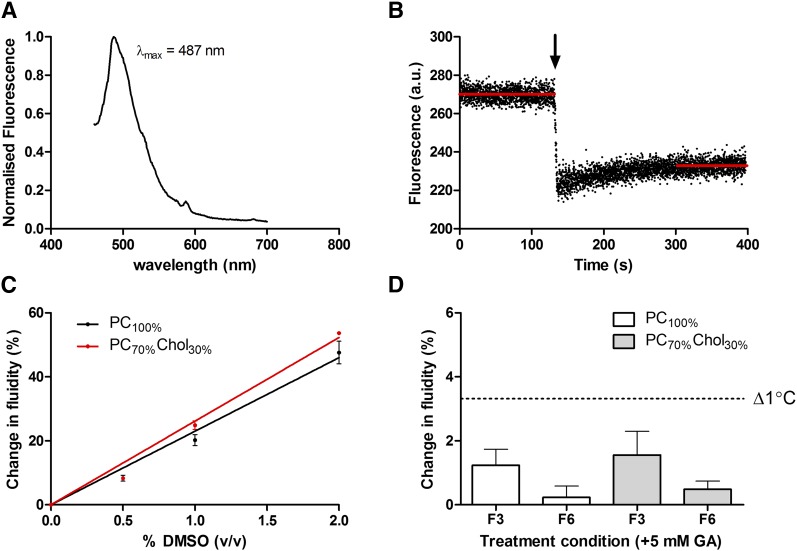
The influence of F3 and F6 on membrane fluidity. A: Normalized emission spectra of DCVJ-labeled PC100% liposomes (400 μM liposomes with 1.5 μM dye) in HEPES buffered saline (pH 7.4) at 37°C exhibits peak fluorescence emission of 487 nm, similar to that previously reported for PC liposomes (49). B: Addition of 2% DMSO to DCVJ-labeled PC100% liposomes at 37°C induced a reduction in DCVJ fluorescence indicative of an increase in membrane fluidity in agreement with the reported behavior of this molecule in PC- and cholesterol-containing membranes (53, 54). C: A concentration-dependent change in membrane fluidity (DCVJ fluorescence intensity ratio) was observed on addition of DMSO to PC100% and PC70%Cholesterol30% [PC70%Chol30%] liposomes at 37°C. On fitting this data to a linear regression model, DMSO was found to induce a significantly greater change in membrane fluidity in PC70%Chol30% membranes, perhaps indicative of disassembly of cholesterol-containing domains (extra sum-of-squares F-test, P = 0.0246). D: Addition of F3 and F6 to liposomes was observed to induce an increase in membrane fluidity with F3 modulating the membrane fluidity to a greater extent than F6. The extent of membrane fluidity modulation was, however, slight and less than that typically attributed to a change in temperature of 1°C (Table 2). As mammalian brain temperatures are reported to fluctuate under physiological conditions by up to 3°C (93), this strongly suggests that modulation of membrane fluidity is not responsible for GA action.